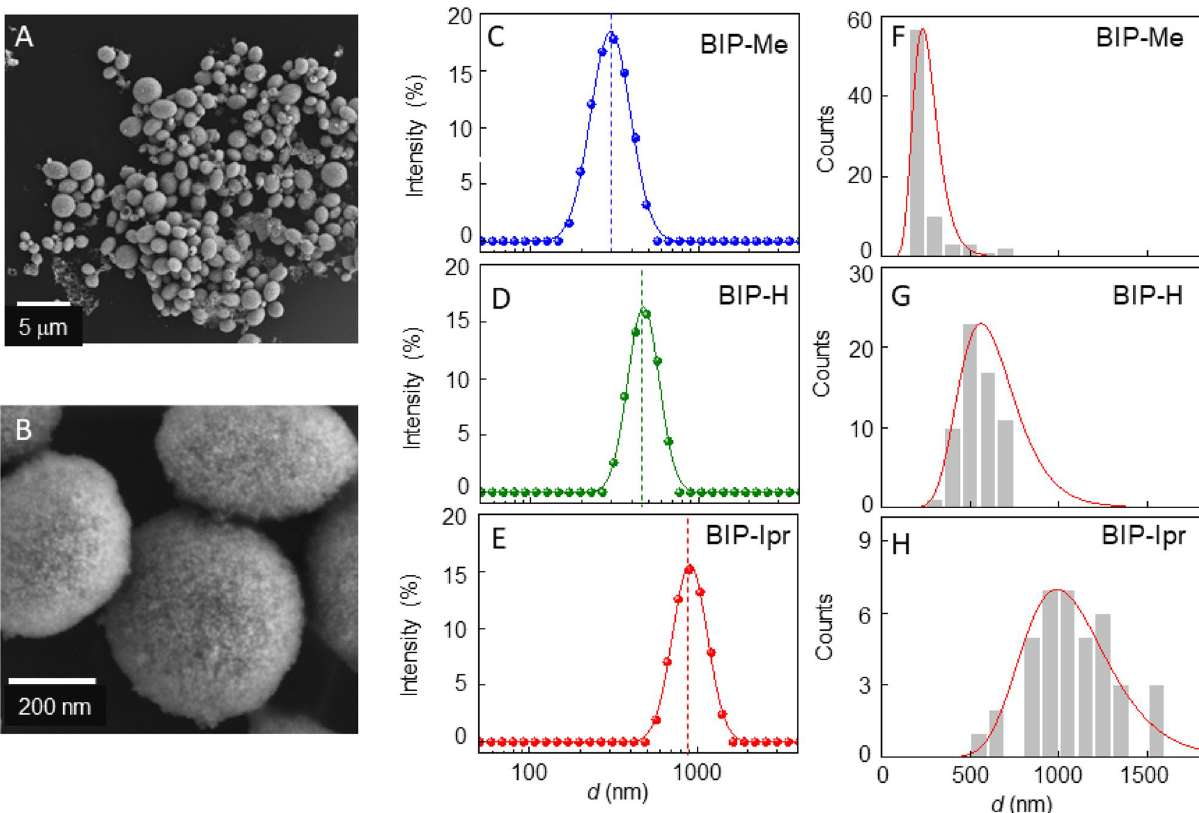
Figure 3. ( A , B ) SEM images of shell ensembles in a typical synthesis ( C – E ) DLS data of ensembles of shells for each of the BIP ligands. ( F – H ) Shell size distribution obtained from image analysis of multiple samples of each kind for the three different BIP